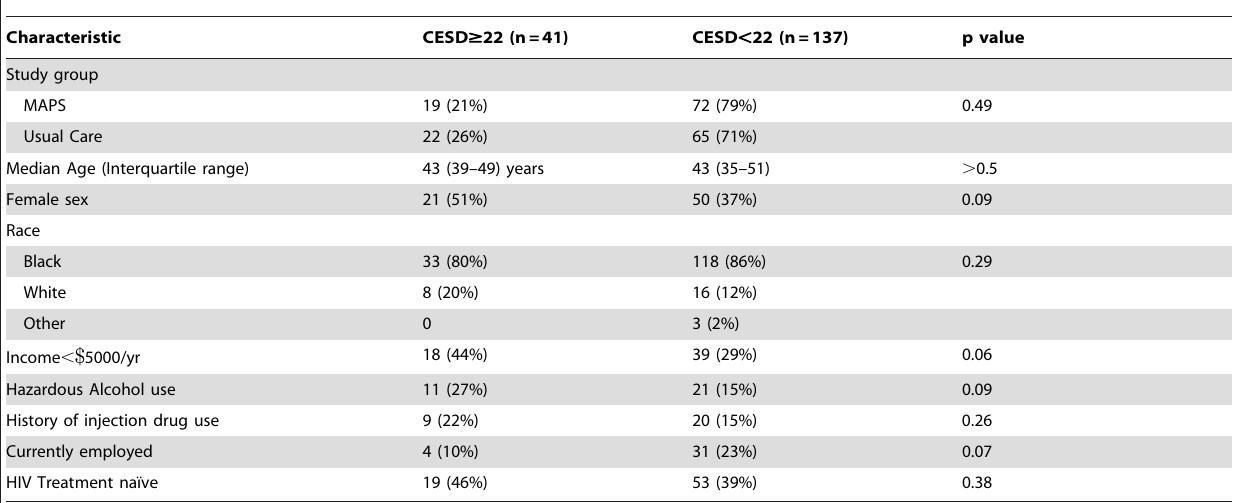
Table 1. Baseline Characteristics by Depressive